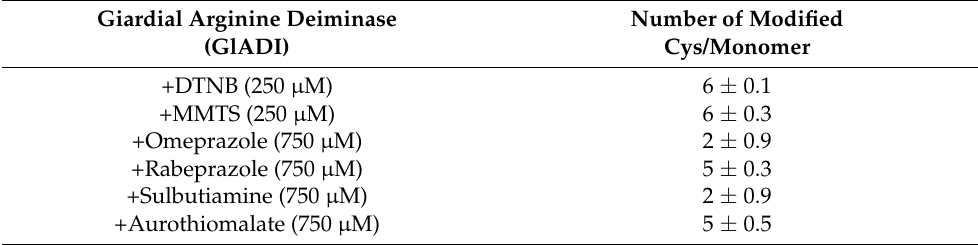
Table 2. Number of modified Cys residues per